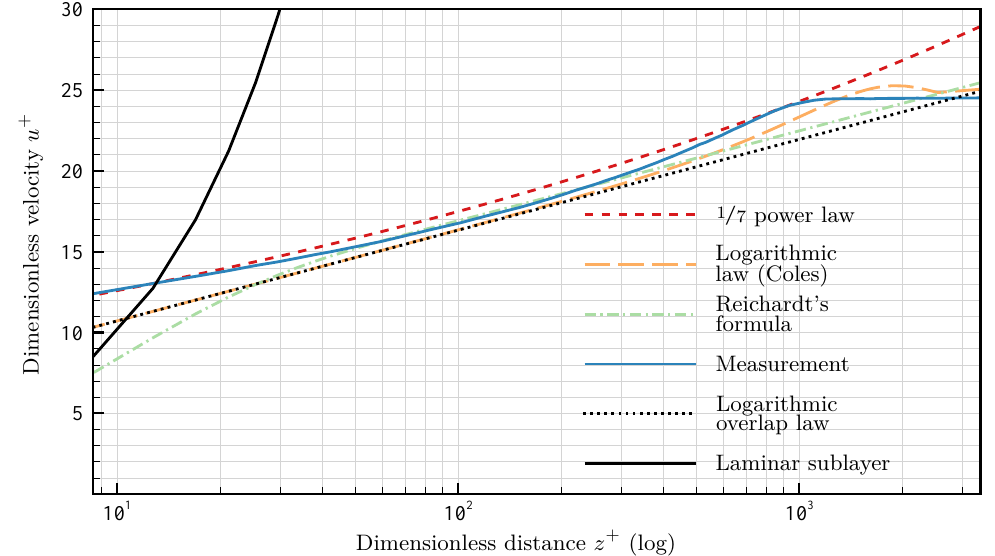
Figure 9. Dimensionless velocity profiles of the turbulent presumed boundary layer at 45ms − 1 in case of shear stress 1 with a distance of x = 350mm from the nozzle